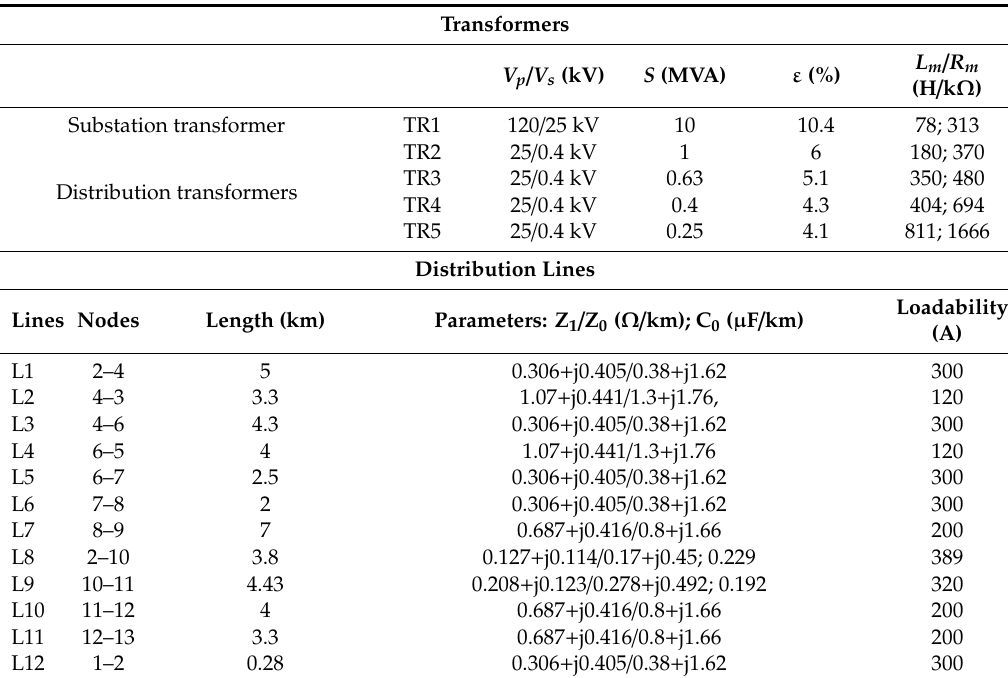
Table A1. Test system